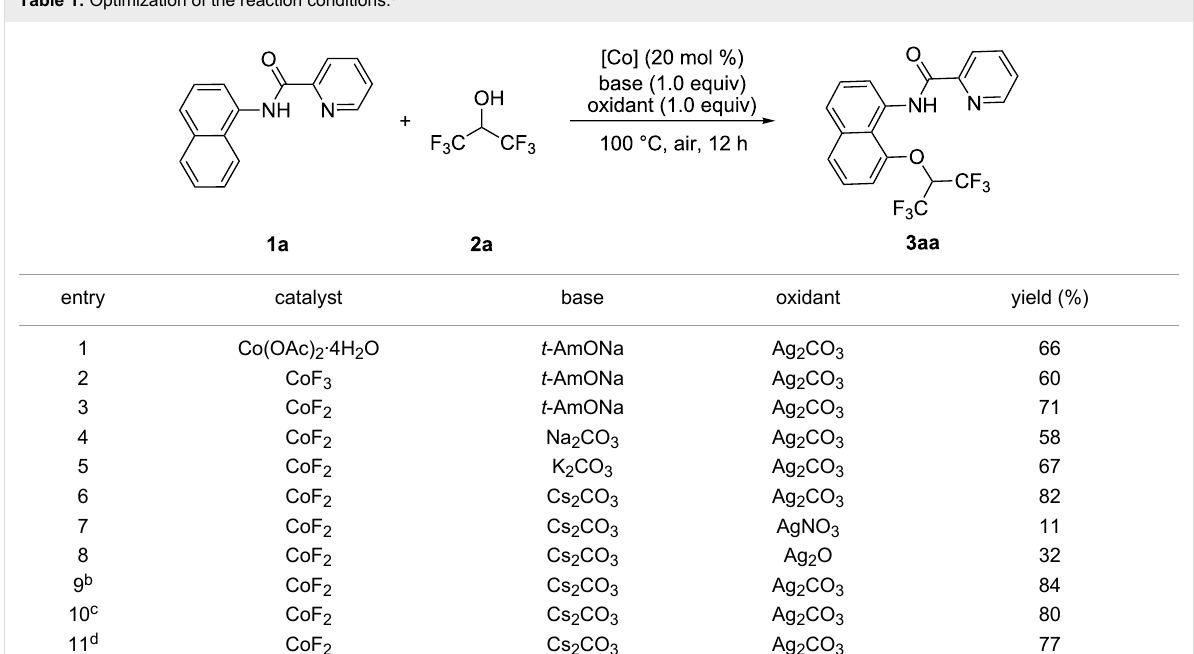
Table 1: Optimization of the reaction conditions.